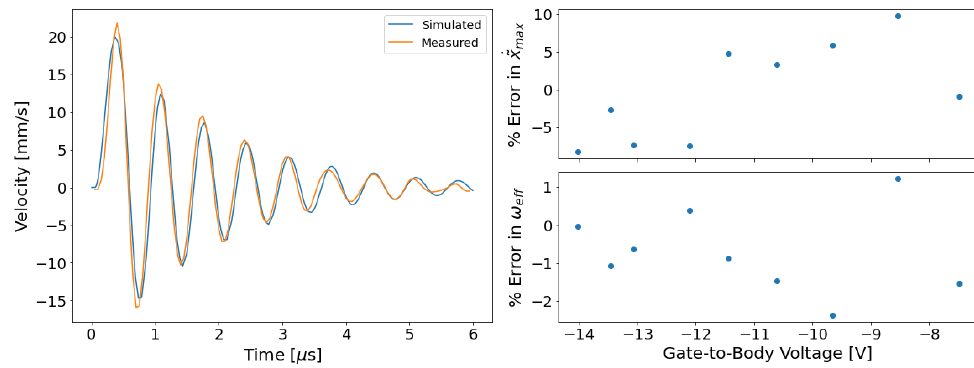
Figure 6. Simulations of the behavioral model developed in this work were compared against velocity measurements. ( left ) A plot of the measured and simulated velocity responses overlaid. The applied body voltage was 12.8 V and the gate voltage was stepped from − 1 V to 1 V. ( right ) A summary of the error in figures of merit—frequency of oscillation and peak velocity—in many comparisons between simulated and measured